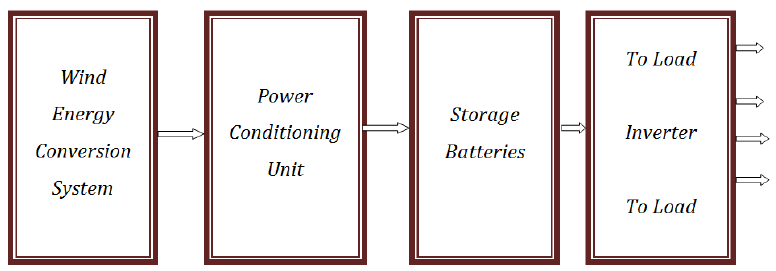
Figure 1. Block diagram of a wind energy generation system.